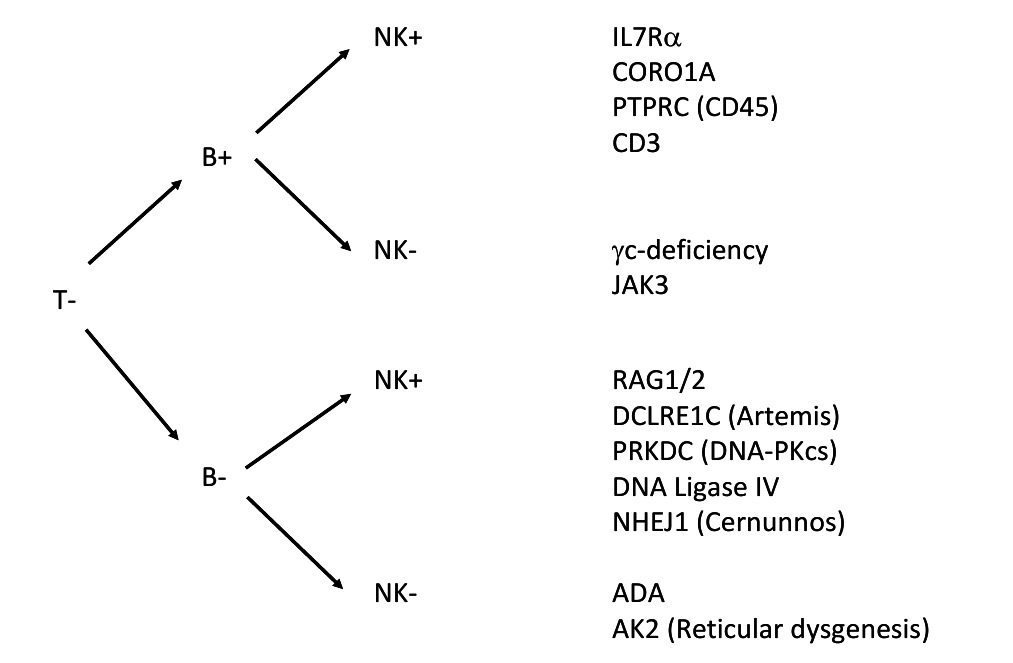
Figure 1. Severe combined immunodeficiency (SCID) forms and genetic defects. IL7Rα, Interleukin-7 receptor α subunit; CORO1A, Coronin, actin binding protein, 1A; PTPRC, Protein tyrosine phosphatase, receptor type, C;  c-deficiency, common  chain of cytokine receptor deficiency; JAK3, Janus kinase 3; RAG1/2, Recombination activating gene 1/2; DCLREC1C, DNA cross-link repair 1C; PRKDC, Protein kinase, DNA-activated, catalytic polypeptide; NHEJ1, Nonhomologous end-joining factor 1; ADA: Adenosine deaminase; AK2, Adenylate kinase